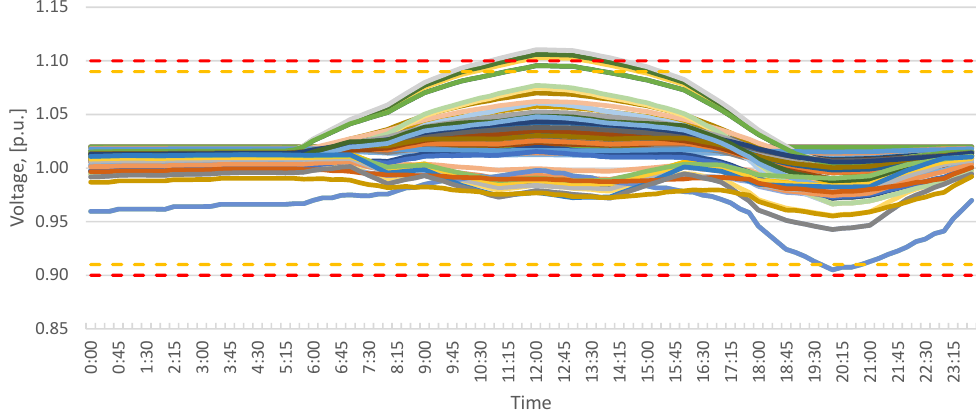
Figure 9. Baseline voltage profiles before the application of the LVC.